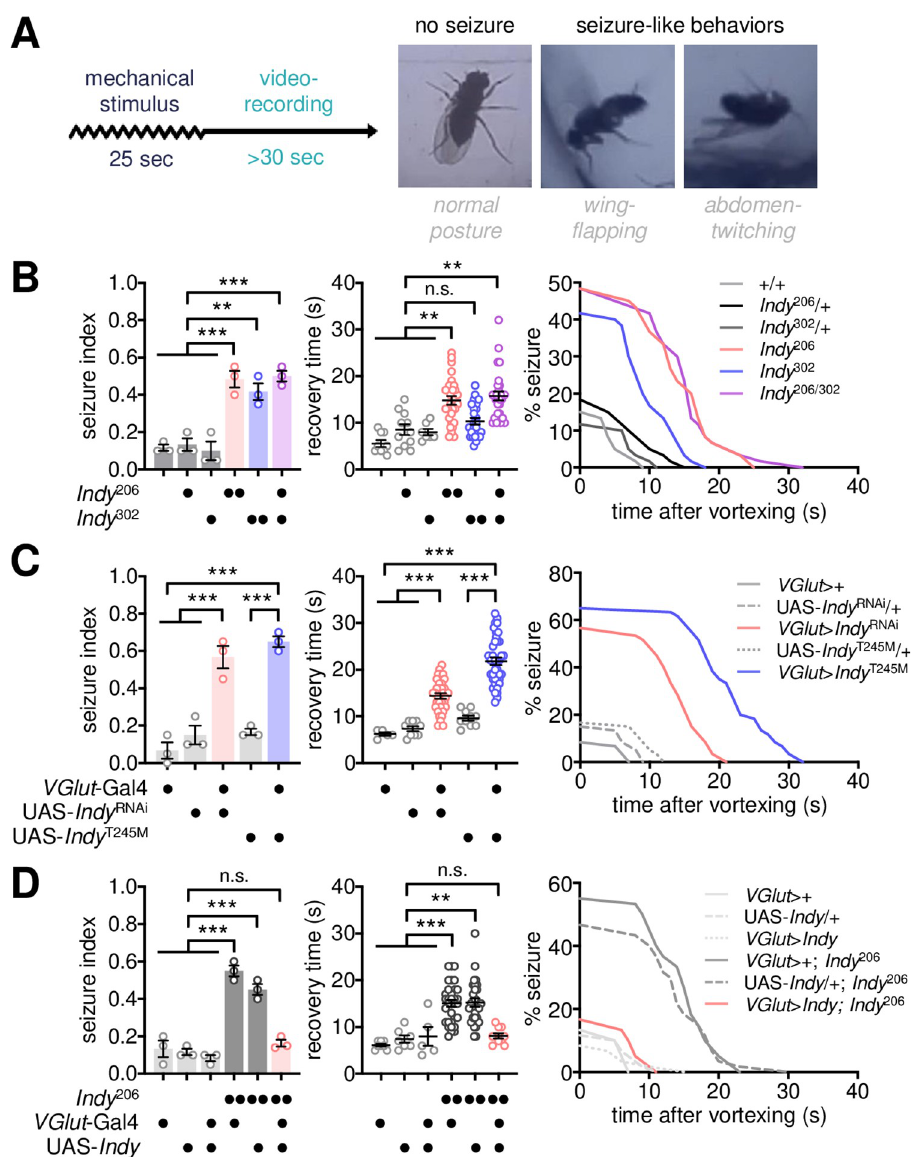
Fig 1. Loss of Indy function in glutamatergic neurons induces BSS. (A) Experimental design for the quantitative analysis of bang-induced seizure-like behaviors in Drosophila . A group of flies (n = 5) was vortexed for 25 s, after which post-stimulus responses were video recorded. Seizure-like behaviors, including wing-flapping and abdomen- twitching, were scored in individual flies. (B) Quantitative analyses of BSS in Indy mutants homozygous or trans- heterozygous for loss-of-function alleles. A seizure index was calculated as the ratio of the number of BSS-positive flies to the total number of flies tested in each experiment (n = 20; 5 flies per group × 4 groups per experiment) and averaged from three independent experiments. Recovery time was calculated individually for BSS-positive flies as the latency to normal posture after vortexing and was averaged for each genotype (n = 7–29 flies). Percent seizure was calculated as the percentage of BSS-positive flies per genotype at each second after vortexing (n = 60 flies; 20 flies per experiment × 3 experiments). Data represent means ± SEM. n.s., not significant; �� P < 0.01, ��� P < 0.001, as determined by one-way ANOVA with Holm-Sidak’s multiple comparisons test (seizure index) or by Kruskal Wallis test with Dunn’s multiple comparisons test (recovery time). (C) Silencing of Indy function in glutamatergic neurons by transgenic overexpression of Indy RNAi or KTS-associated Indy T245M is sufficient to induce BSS. Quantitative analyses of BSS in individual flies were performed as described above. Data represent means ± SEM (seizure index, n = 60 flies in 3 independent experiments; recovery time, n = 5–39 flies). ��� P < 0.001, as determined by one-way ANOVA with Holm-Sidak’s multiple comparisons test. (D) Transgenic overexpression of wild-type INDY in glutamatergic neurons rescues BSS in Indy mutants. Data represent means ± SEM (seizure index, n = 60 flies in 3 independent experiments; recovery time, n = 5–33 flies). n.s., not significant; �� P < 0.01, ��� P < 0.001, as determined by two-way ANOVA with Holm-Sidak’s multiple comparisons